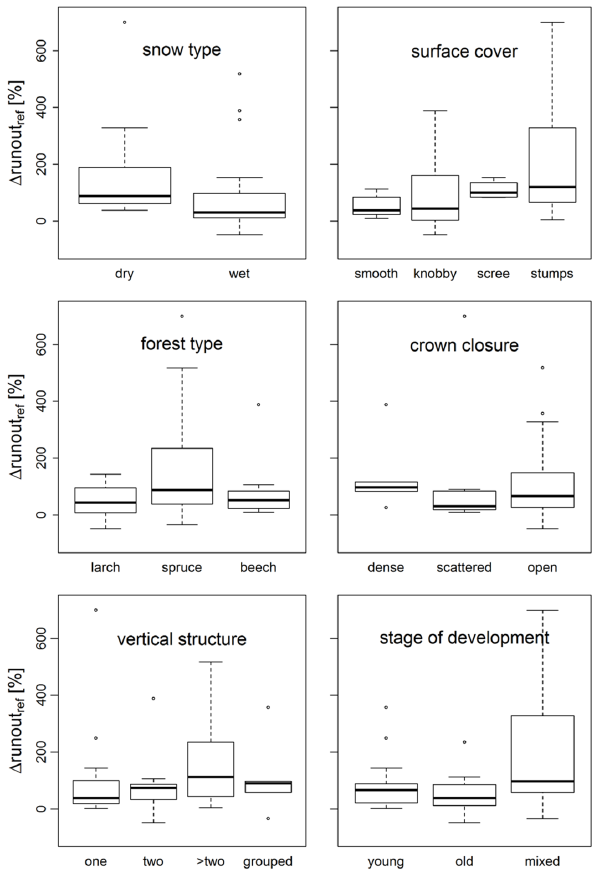
Figure 3. Difference between simulated and observed runout dis- tances ( 1 runout ref ) calculated for the reference simulation runs without any forest influence ( K = 0) shown for the subsets of vari- ables snow type and small-scale surface cover which are statisti- cally significant (first row) and for the subsets of four other for- est structural parameters (no statistically significant relationships). Boxplots show minimum values, the lower quantile ( Q 0.25), the median ( Q 0.5), the upper quantile ( Q 0.75) and maximum values of 1 runout ref . Points are relative positions of extreme values.